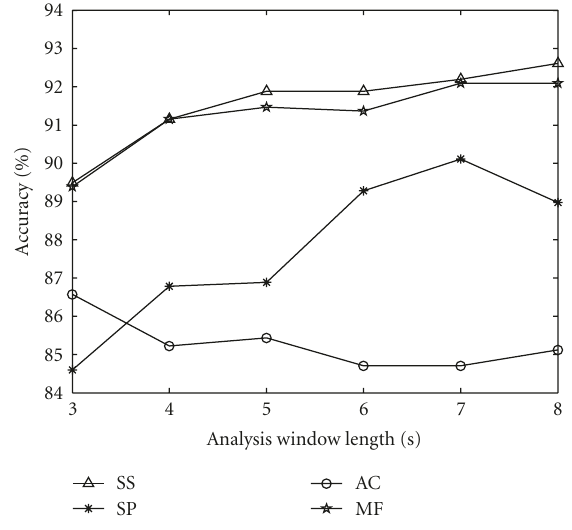
Figure 10: On the influence of window